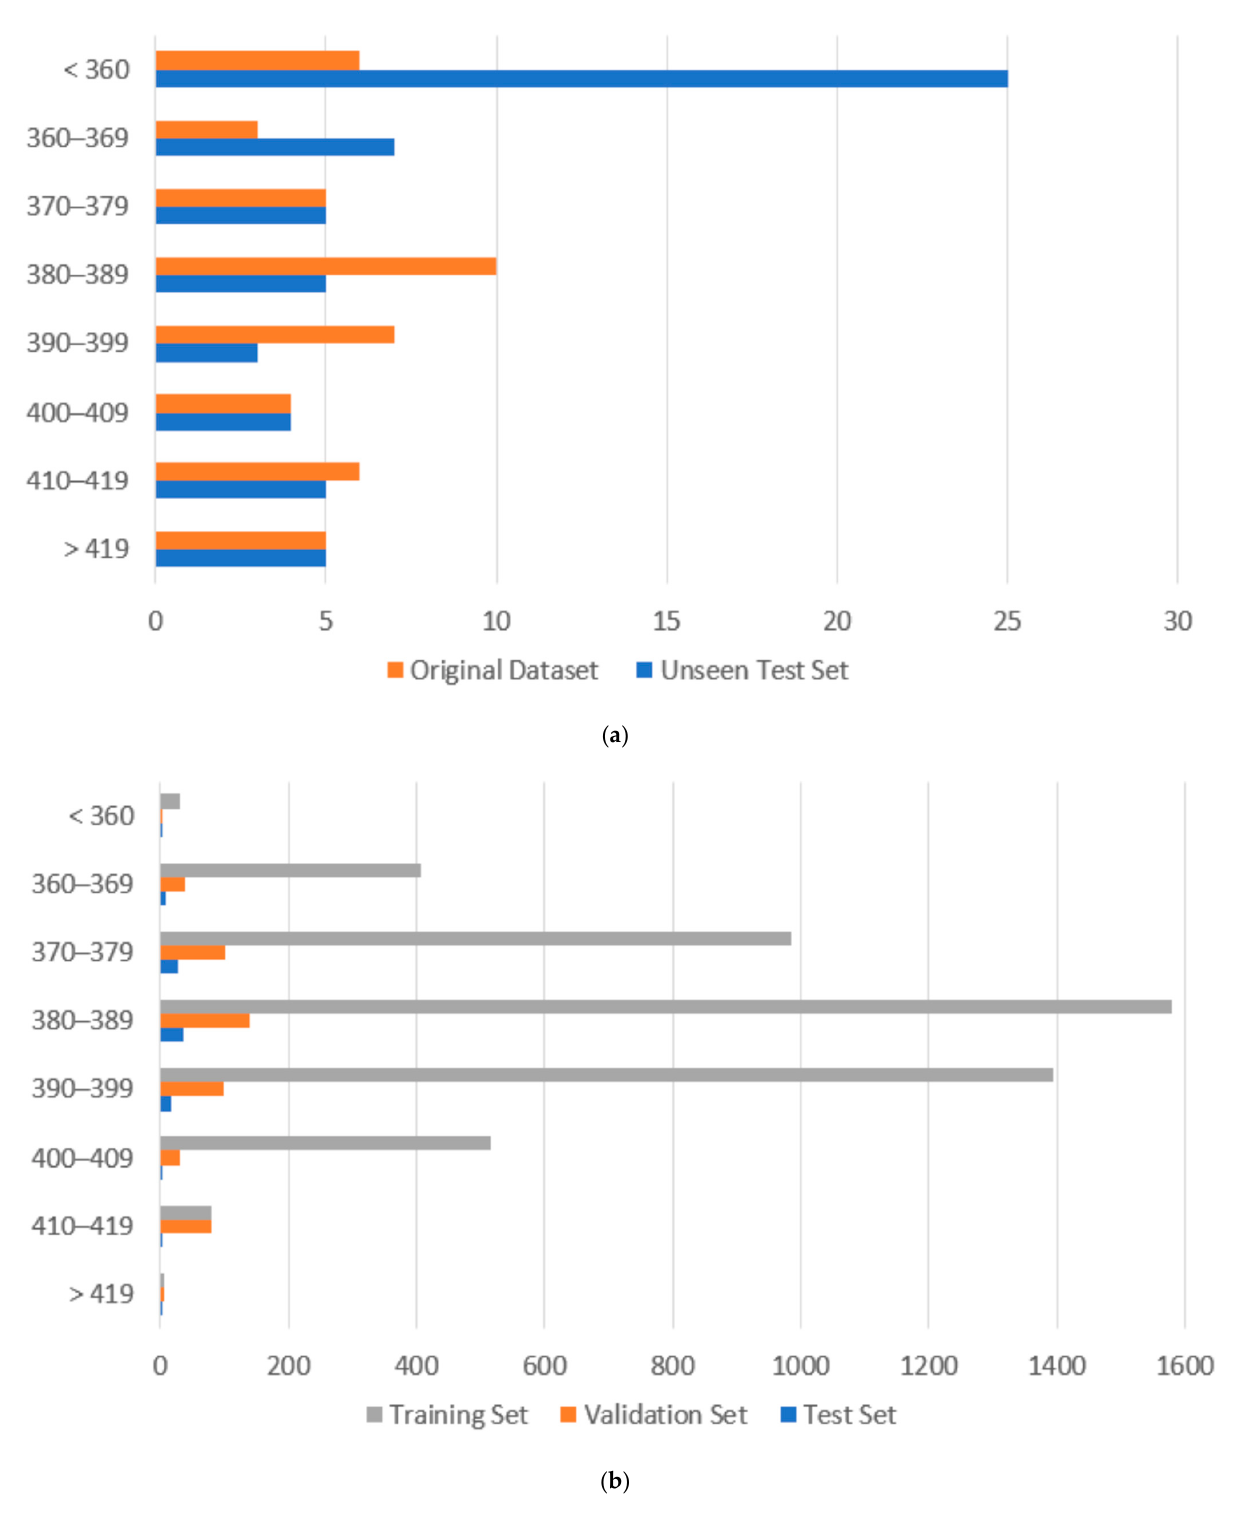
Figure 8. ( a ) Distribution of the original and unseen dataset; ( b ) distribution of the mixed datasets for training and testing the developed models.